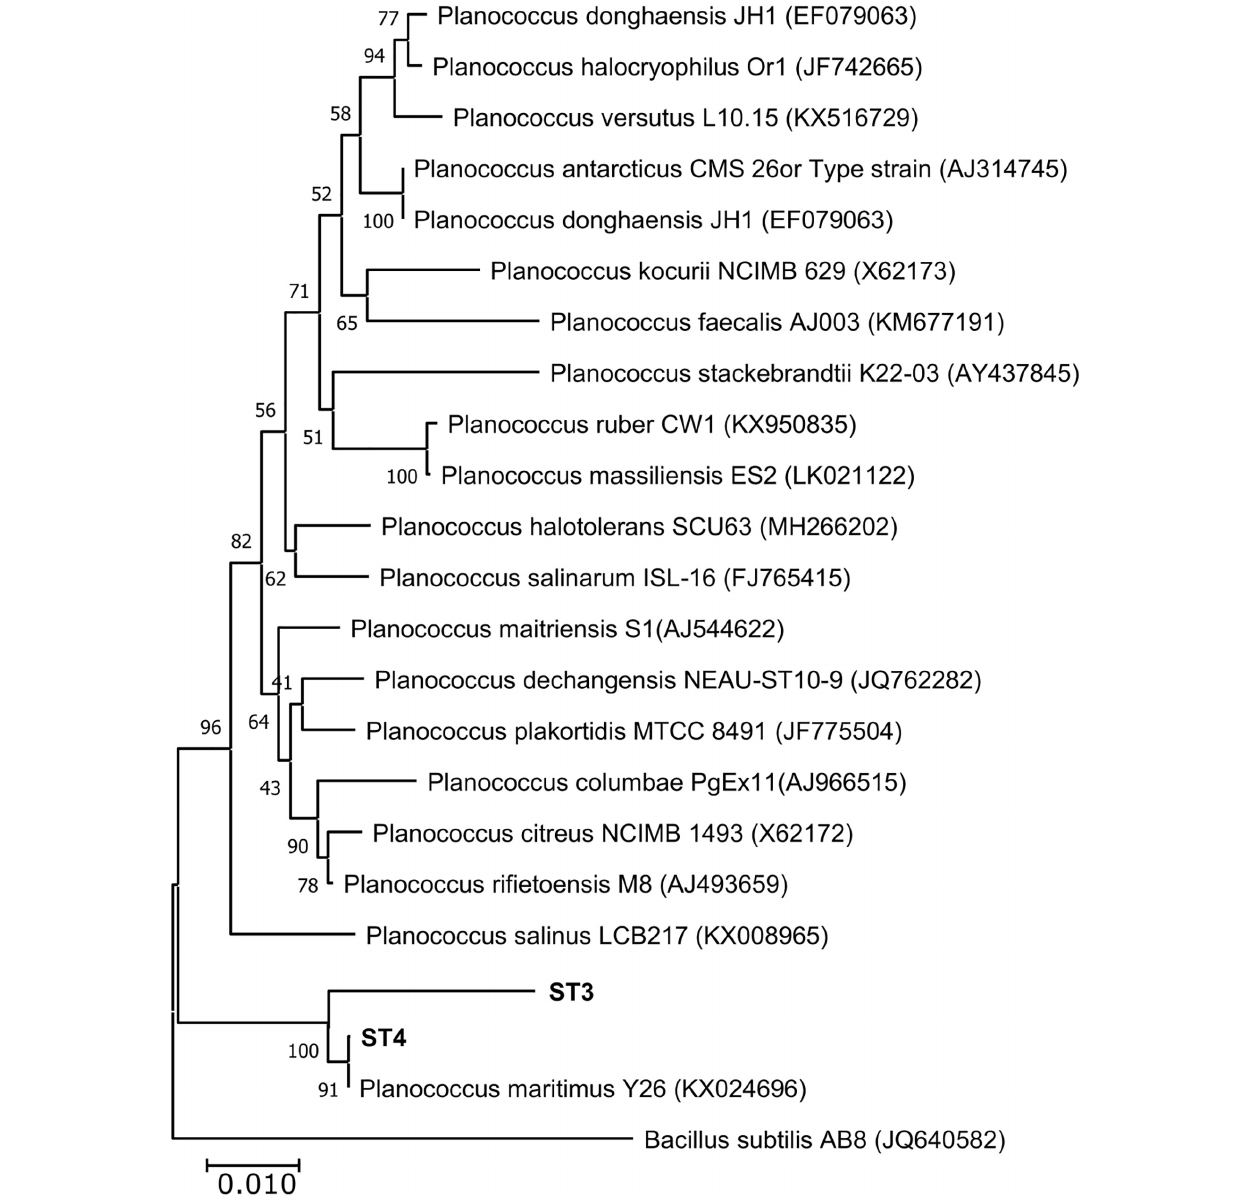
SOS levels, in contrast to ST3 and ST4 where these levels were